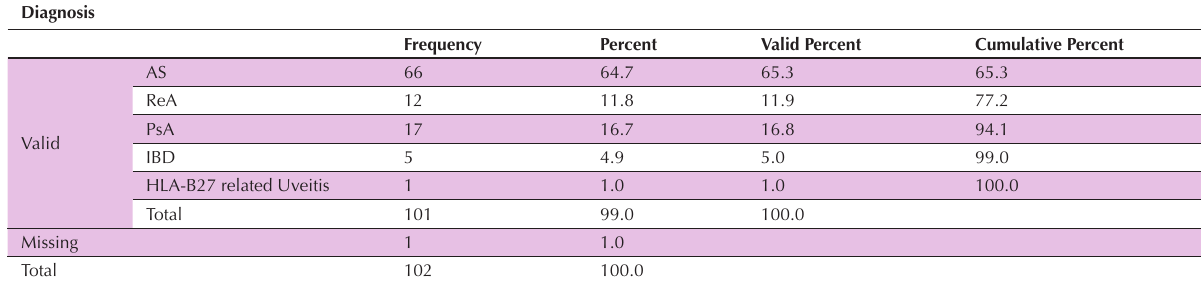
Table 3. Frequency and percentage of patients with different subtypes of spondyloarthropathy in the study Diagnosis